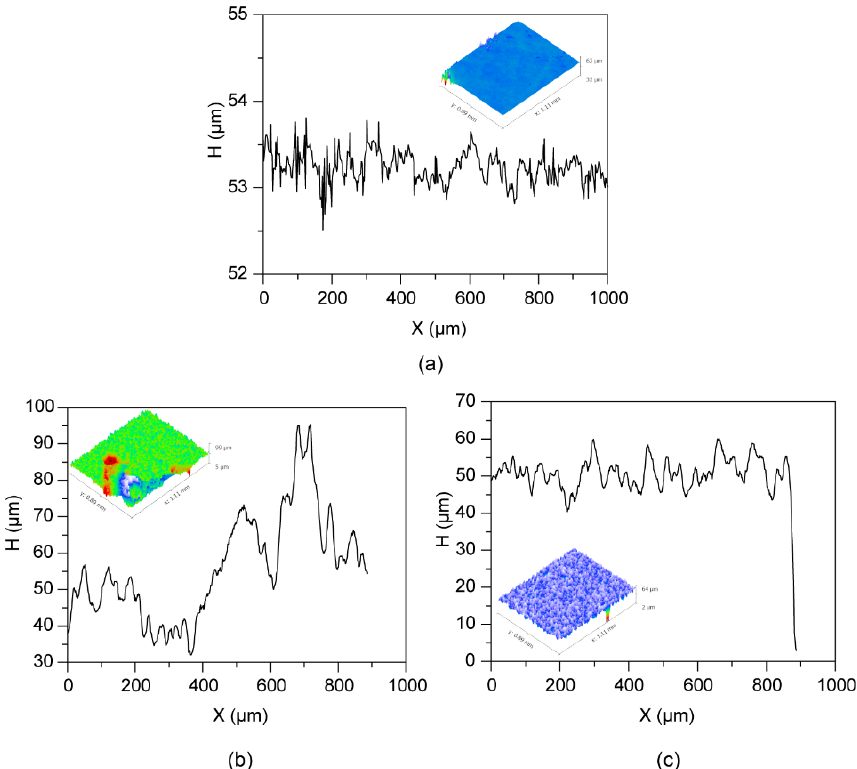
Figure 3. Wear morphology of three-dimensional and two-dimensional front edge: (a) wear morphology of front cutting edge of cutter before cutting, (b) wear morphology of front cutting edge of CT cutter znd (c) wear morphology of front cutting edge of TT